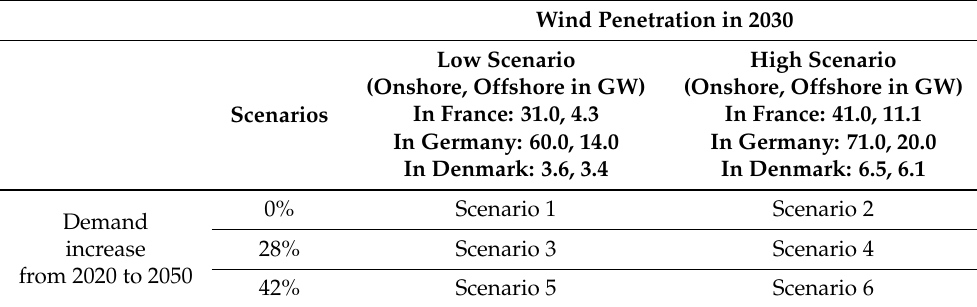
Table 1. Wind energy penetration and electricity demand scenarios used to build price scenarios in each